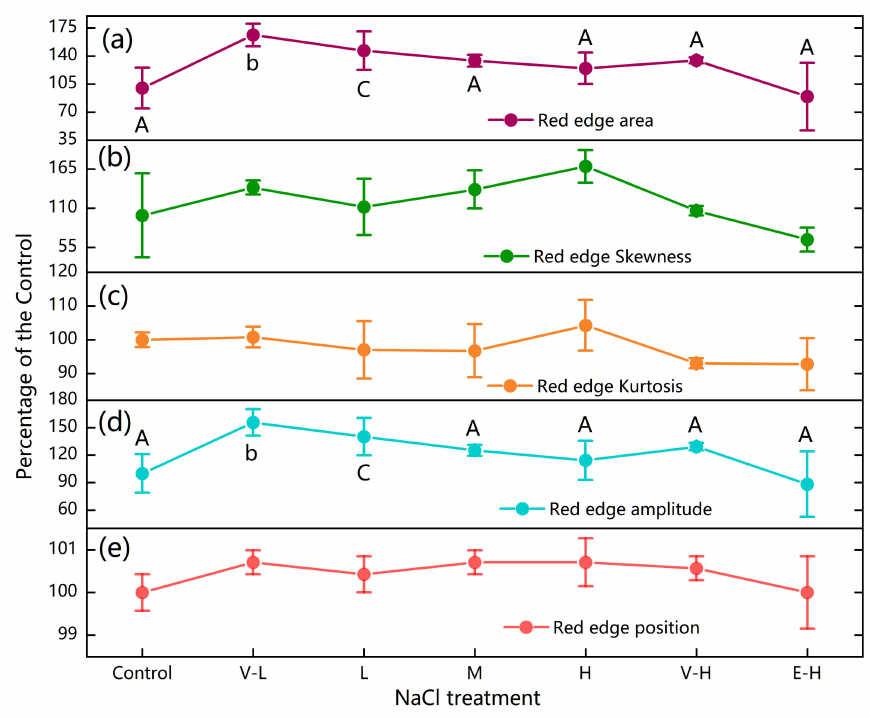
Figure 5. Trend of red edge area ( a ), skewness ( b ), kurtosis ( c ), amplitude ( d ) and position ( e ) of Suaeda salsa under di ff erent NaCl treatments. The control group was set to 100%, and the remaining six groups were changed relative to the control group. The values were means ± standard errors (n = 3). The real values are presented in Table 4. Capital and lower-case letters above the bars indicate significant di ff erences at the levels of 0.05 and 0.01. If no letter is assigned above the band, it means that this item is not significant to salt stress ( p > 0.05). Other descriptions are as in Figure